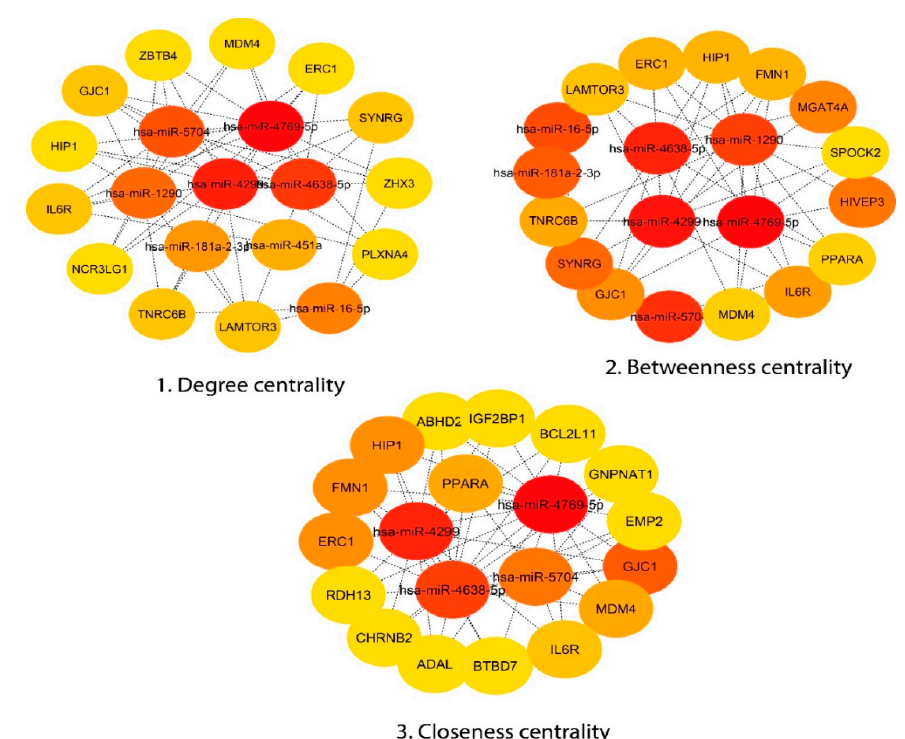
Figure 3. Significant modules and the top 20 ranked genes / proteins of the network based on ( 1 ) degree, which includes 20 nodes and 52 edges; ( 2 ) betweenness, which includes 20 nodes and 50 edges; and ( 3 ) closeness, which includes 20 nodes and 49 edges. The top 20 ranked genes / proteins in the network indicate both gene and miRNA. Red indicates the highest rank, whereas yellow indicates the lowest rank. Based on these modules, 5 hub genes were found to be common in all and considered as significant hub nodes; for miR-16-5p, 3 genes were considered as hub